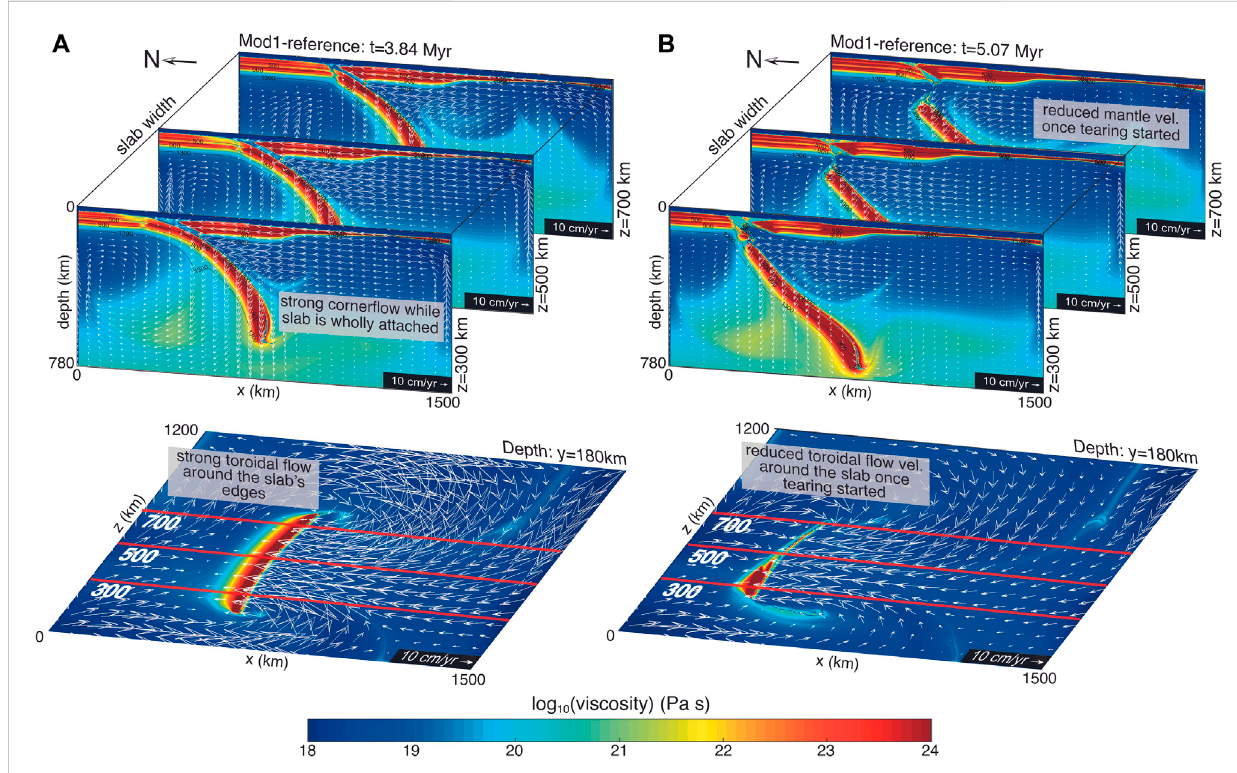
FIGURE 5 Reference model Mod1 viscosity cross-sections and velocity fi eld. The upper panels show the x-y cross-sections from z = 300, 500, and 700 km, while the bottom panels show the x-z cross-sections from the depth y = 180 km, and the red lines correspond to the x-y slices in the panel above. The cross-sections in (A) come from a stage when the lithospheric slab is still wholly attached. The large hanging slab disturbs the mantle fl ow and causes mantle corner fl ow to build up, as well as causing strong mantle fl ow around the slab. The cross-sections in (B) are from the stage after slab tearing has started (on the eastern side). The mantle fl ow velocity diminishes as the slab-tear window allows the mantle to fl ow